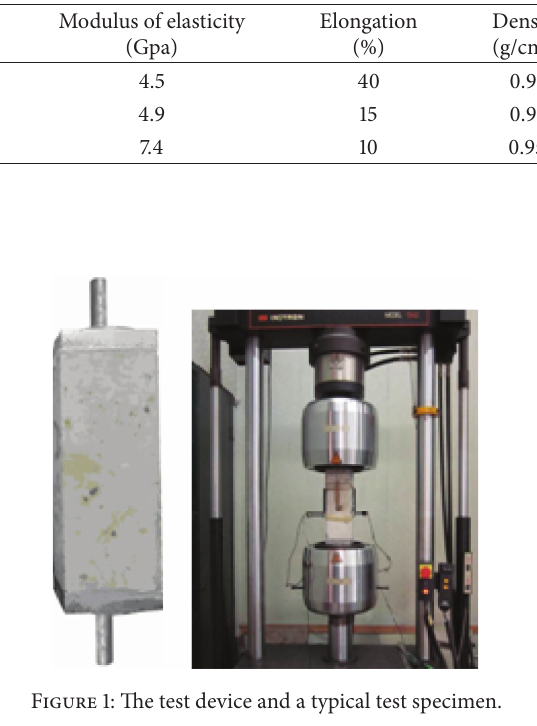
Table 1: Physical and mechanical properties of polypropylene fiber.